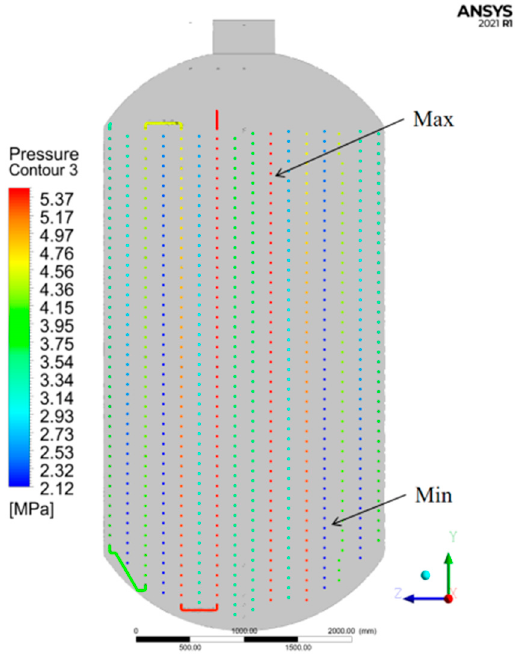
Figure 15. Y-Z plane stress field of coil.